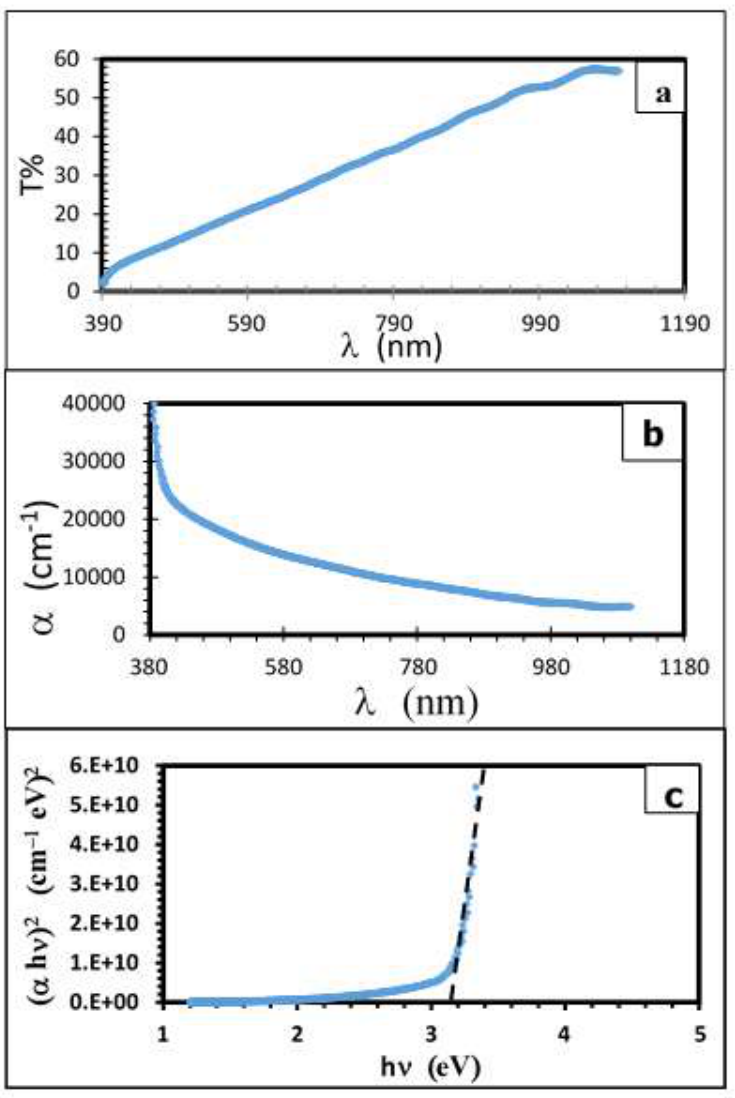
Figure 5: (a) Transmission curves for pure TiO energy gab for TiO 2